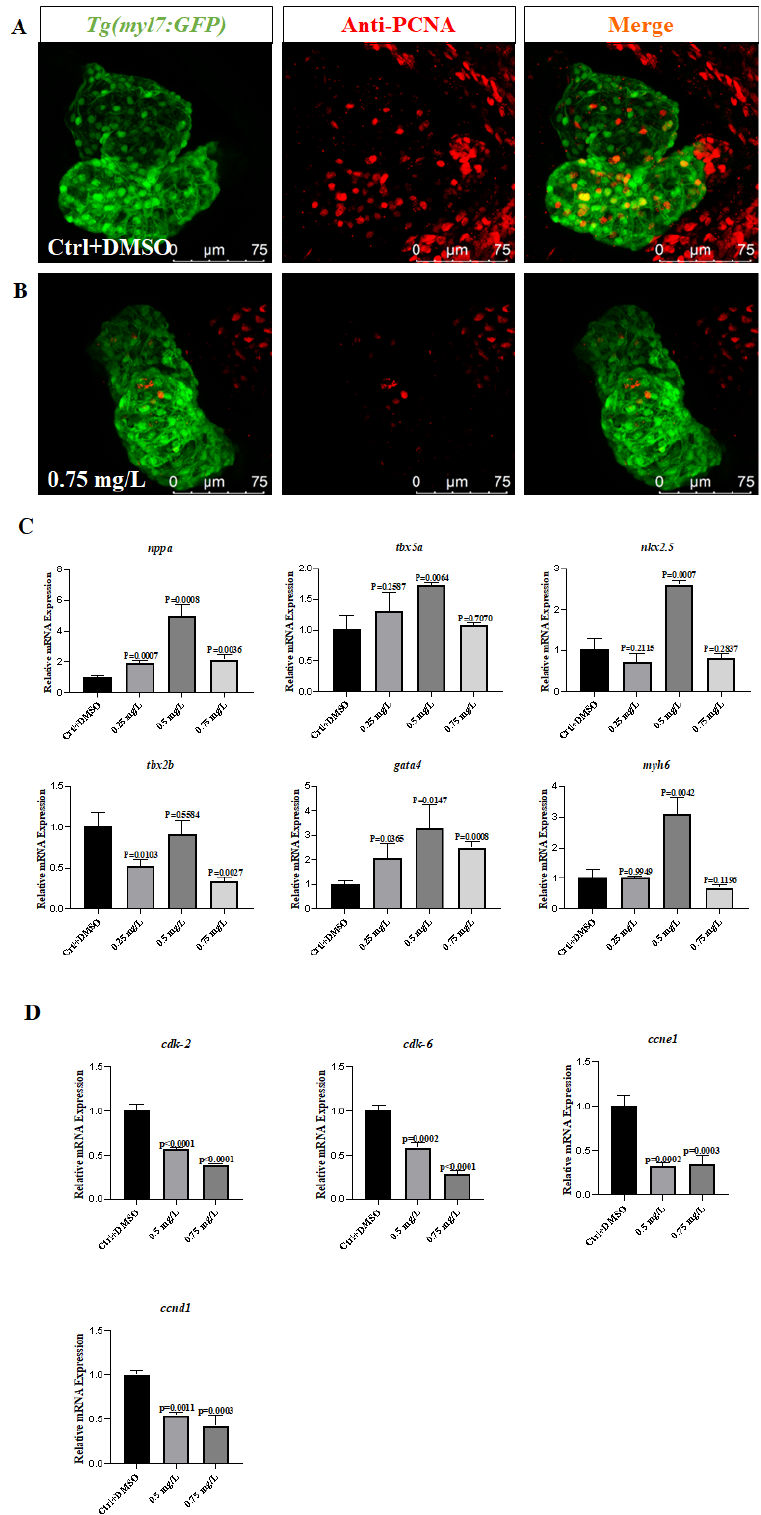
Figure 3. Pentachloronitrobenzene inhibited cardiac proliferation. ( A ). Cardiac proliferation in the Ctrl group (orange represents proliferating cells). ( B ). Cardiac proliferation in the 0.75 mg/L treatment group. ( C ). Expression levels of heart-related genes. ( D ). Cell proliferation-related gene expression. Each difference is a comparison between the control group and the treatment group. ( n = 20, Means ±